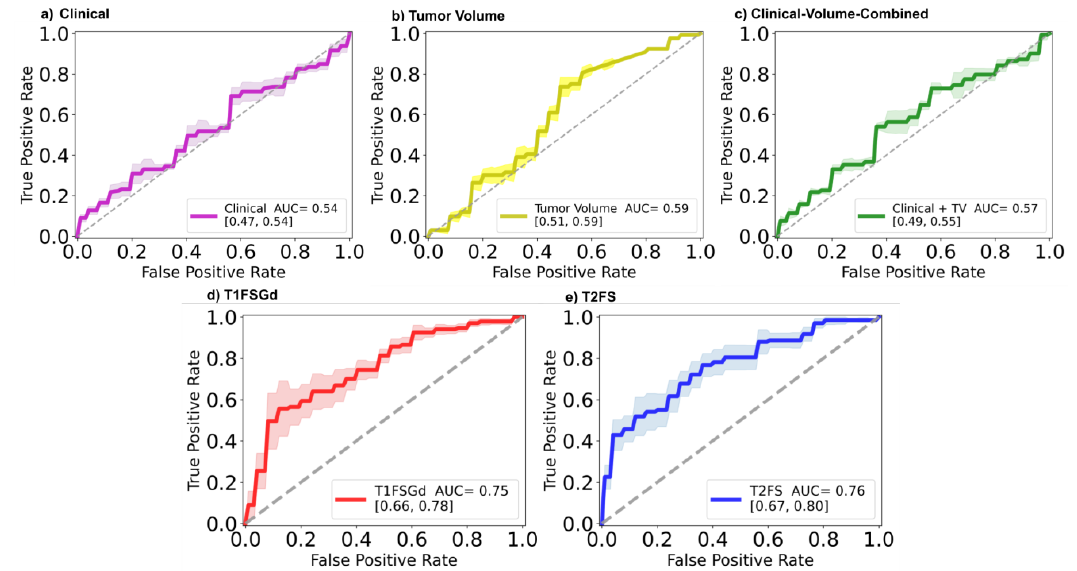
Figure 2. Predictive performance of MRI-based DL models. Receiver operator characteristic curves (ROC) and the respective area under the curve (AUC) values depicting the performance of the prediction models ( a ) Clinical , ( b ) Tumor-Volume , ( c ) Clinical-Volume-Combined , ( d ) DL-T1FSGd , and ( e ) DL-T2FS . Table 2. Classification metrics for the test set. In bold, the best result among all models for each metric is marked.